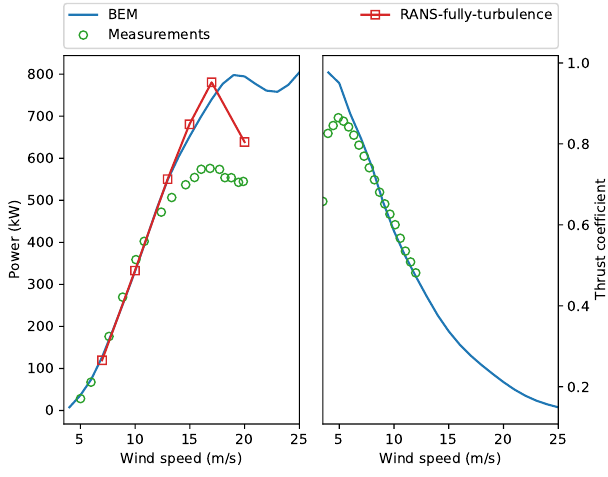
Figure 9. Performance curves of the NTK500/41